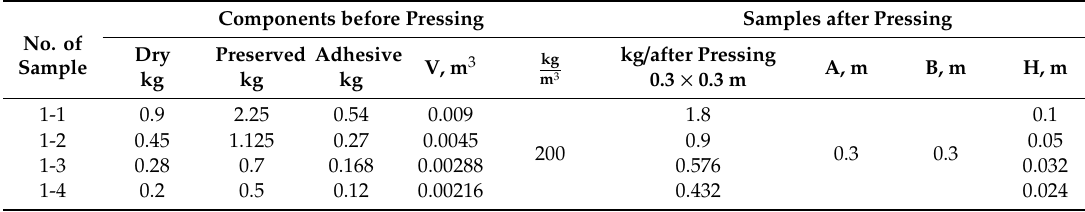
Table 1. Components of the samples from the first series.